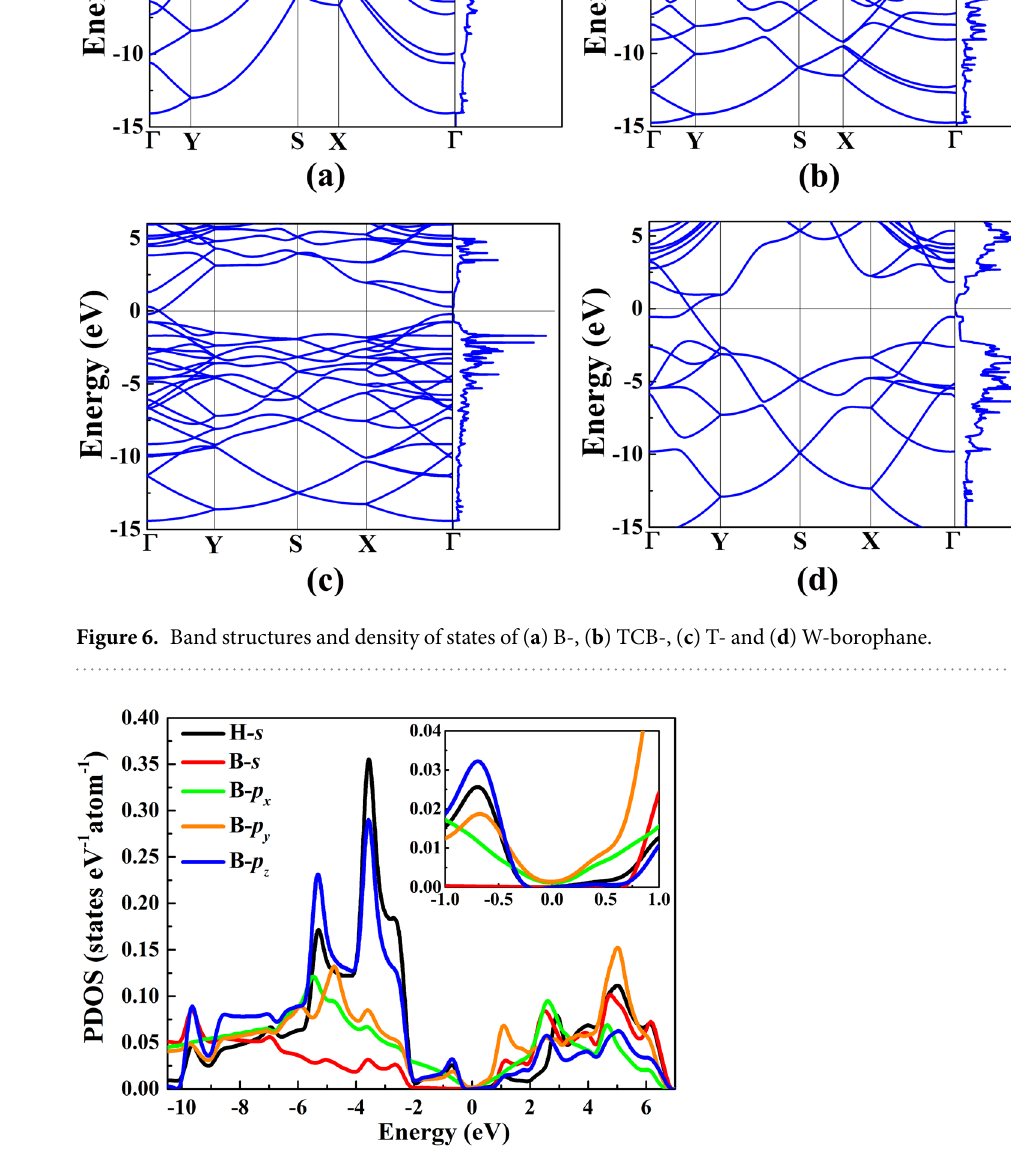
Figure 7. Partial density of states of H and B atoms in